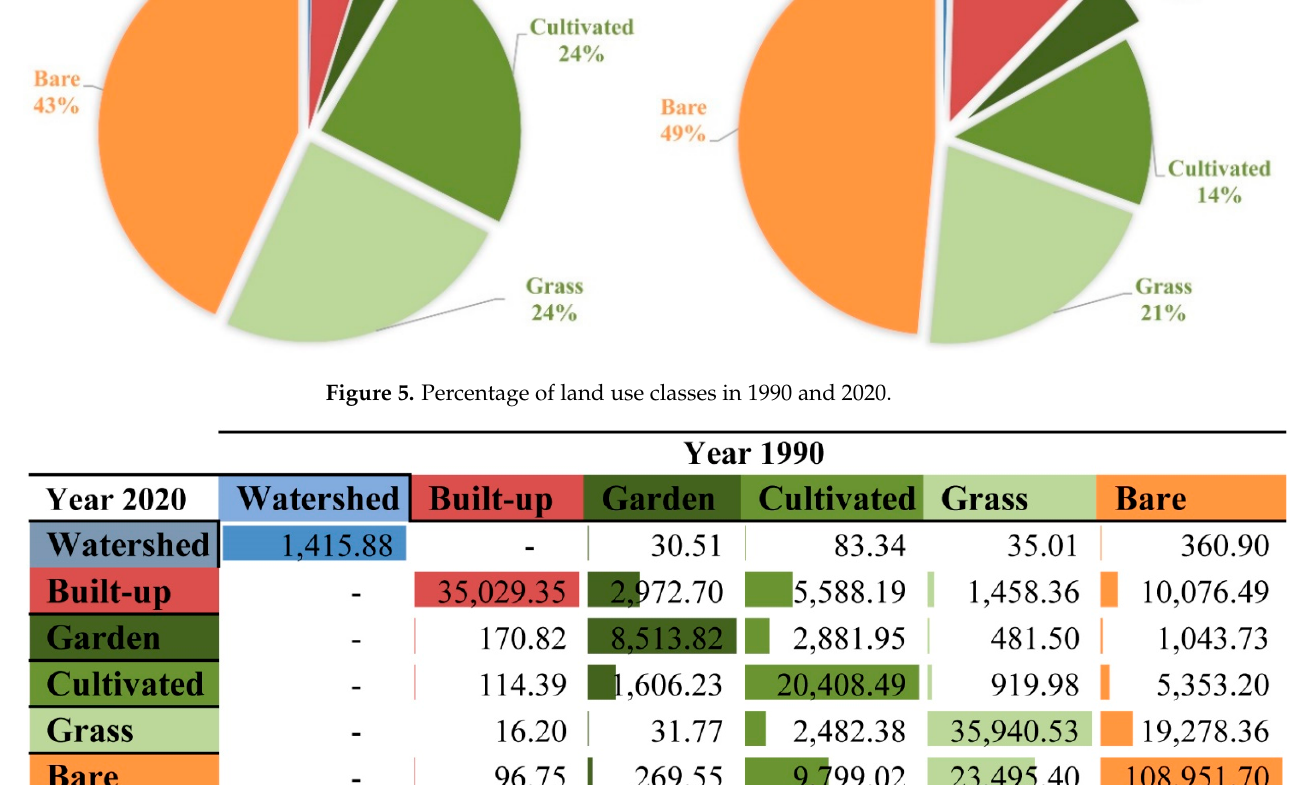
Figure 5. Percentage of land use classes in 1990 and 2020.